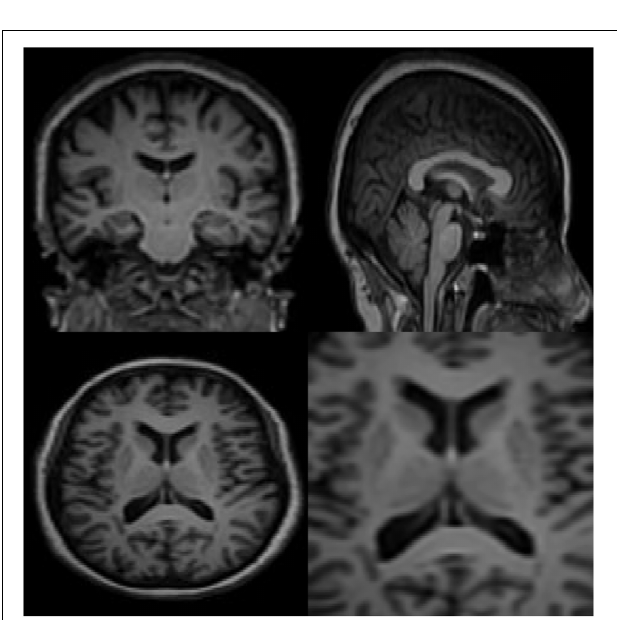
FIGURE 5 | The results of recurrent type-2 fuzzy neural network for two-dimensional interpolation.